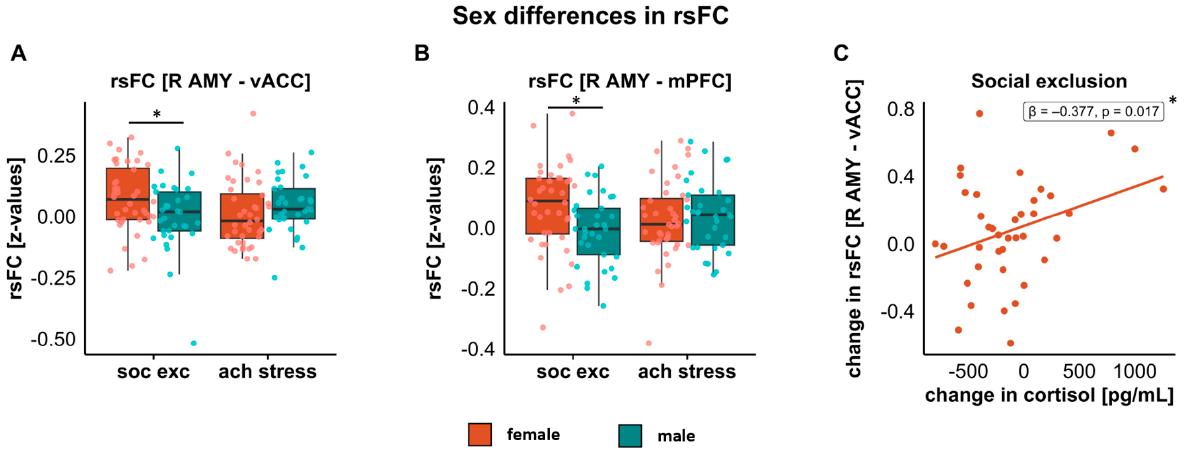
Figure 4. Sex differences for both paradigms in rsFC of right amygdala with vACC ( A ) and mPFC ( B ). ( C ) Association of changes in cortisol with changes in amygdala–vACC rsFC for social exclusion in females. * Indicates significance of p < 0.05. Abbreviations: vACC = ventral anterior cingulate cortex, AMY = amygdala, mPFC = medial prefrontal cortex, soc. exc. = social exclusion, ach. stress = achievement